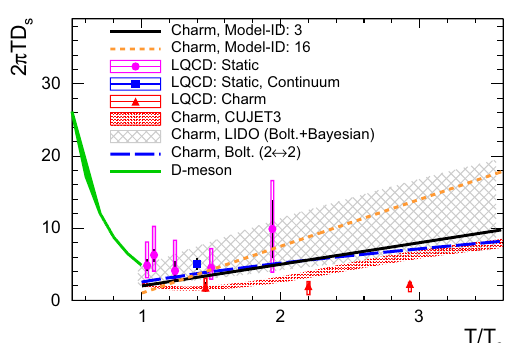
Fig. 2 Spatial diffusion constant 2 π T D s of charm quark from various calculations, including: the LGR Model-A and Model-B, the optimized parameters, lattice QCD calculations (pink circle [49], red triangle [50] and blue square [51]), CUJET3 (red region [52]), a Bayesian analysis in 95% CL from LIDO (shadowed gray band [53]) and a LO calculation with a Boltzmann dynamics (long dashed blue curve [54]). The result for D-meson (dot dashed green curve [55]) in the hadronic phase is also shown for comparison